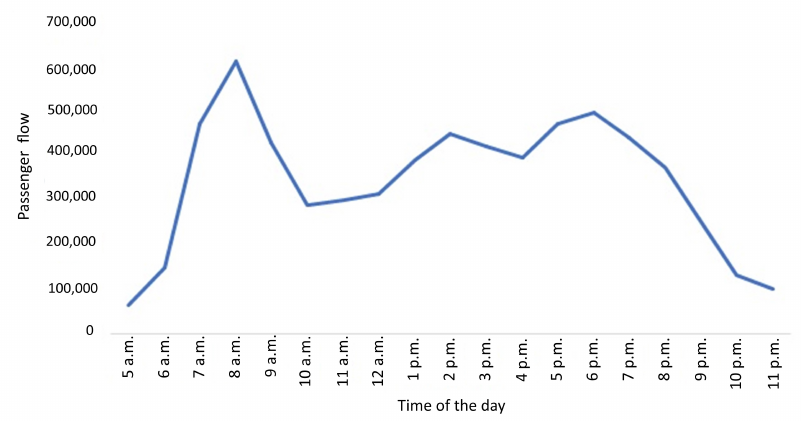
Figure 4. Hourly passenger flow on workdays.